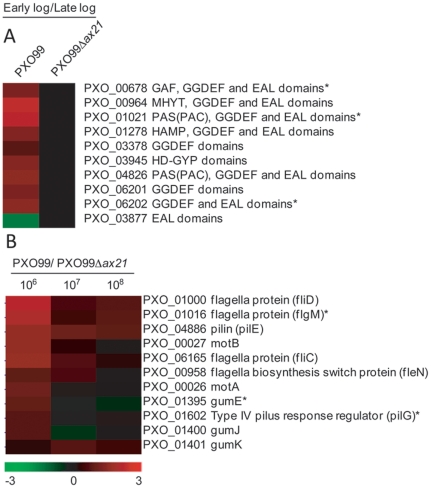
Whole genome transcriptomics of PXO99 vs. PXO99Δax21 at different population densities identifies Ax21-regulated genes.A heat map represents the ratio of gene expression levels in a log2-based pseudocolor scale (red, positive; green, negative). (A) Expression pattern of genes encoding proteins predicted to regulate c-di-GMP turnover in PXO99 (Left) and PXO99Δax21 (Right). (B) Ax21 up-regulated genes that are highly expressed in early log phase including bacterial motility genes and xanthan gum biosynthesis. The functions of the genes marked by a star were assessed for phenotypes in Xoo knockout strains (Figure S13).